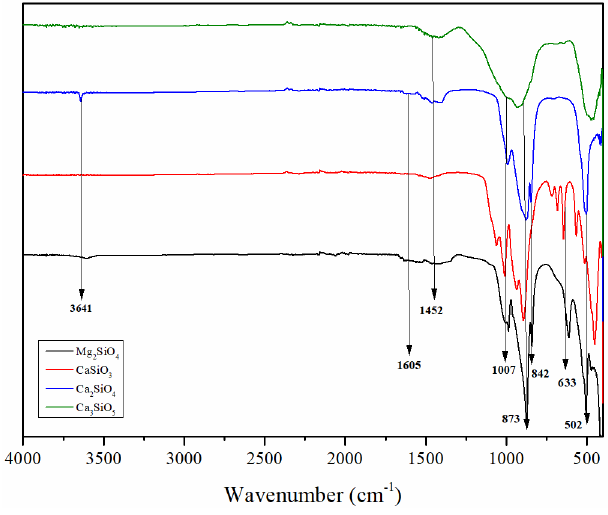
Figure 4. FTIR spectra of the prepared silicate fillers.